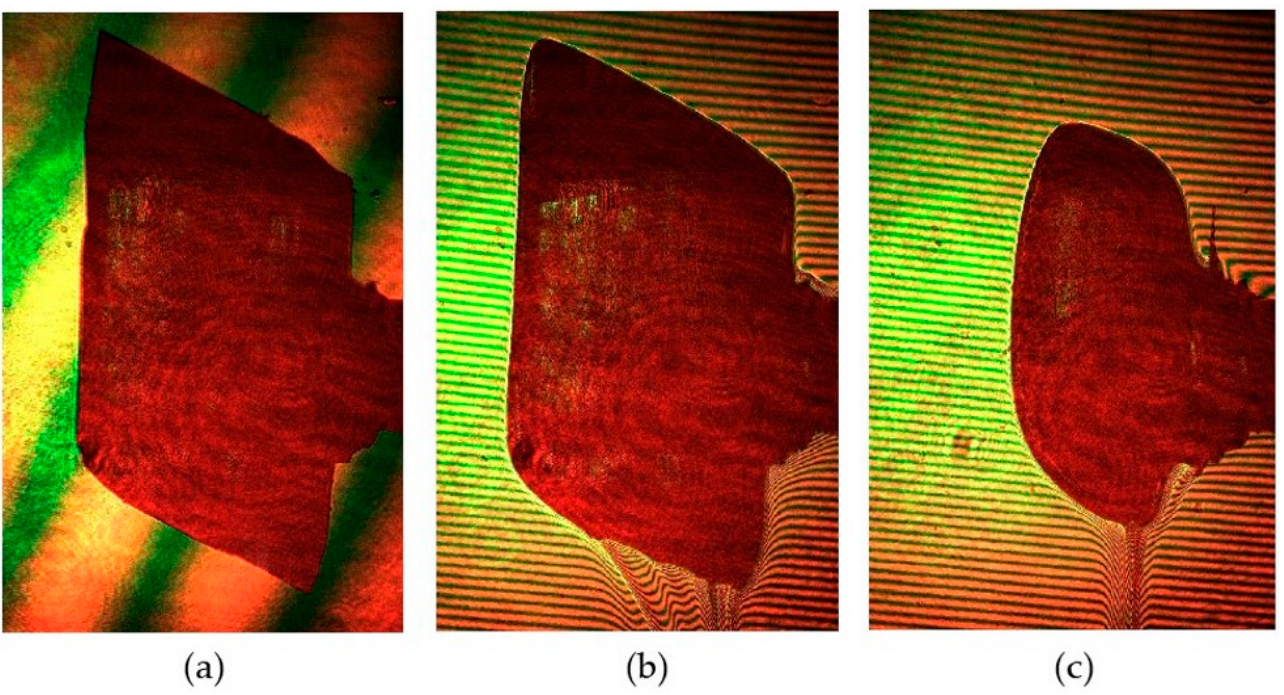
Figure 8. Development of crystal shape during a dissolution experiment with v = 92 mm/s and c = 0.16 g/g ( a ) before filling, ( b ) first image after filling, ( c ) last image, taken after 6.5 min.